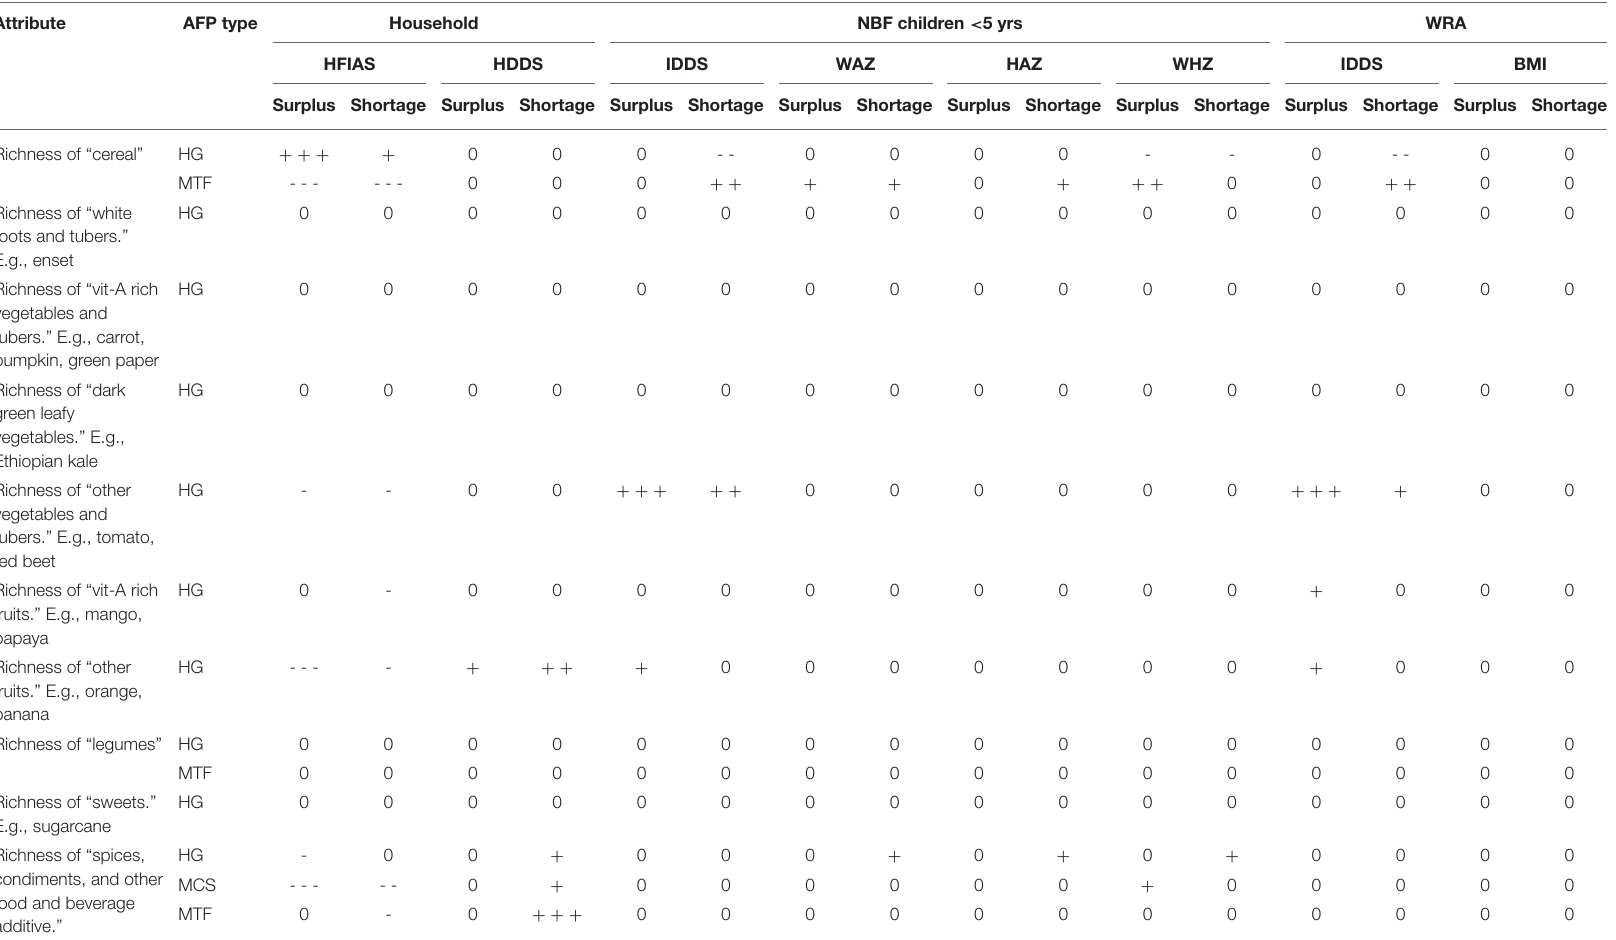
TABLE 4 | Pearson correlation among species nutritional diversity traits of the three dominant agroforestry practices, against food and nutrition security status indices of two sensitive groups or smallholders in Yayu during shortage and surplus seasons.